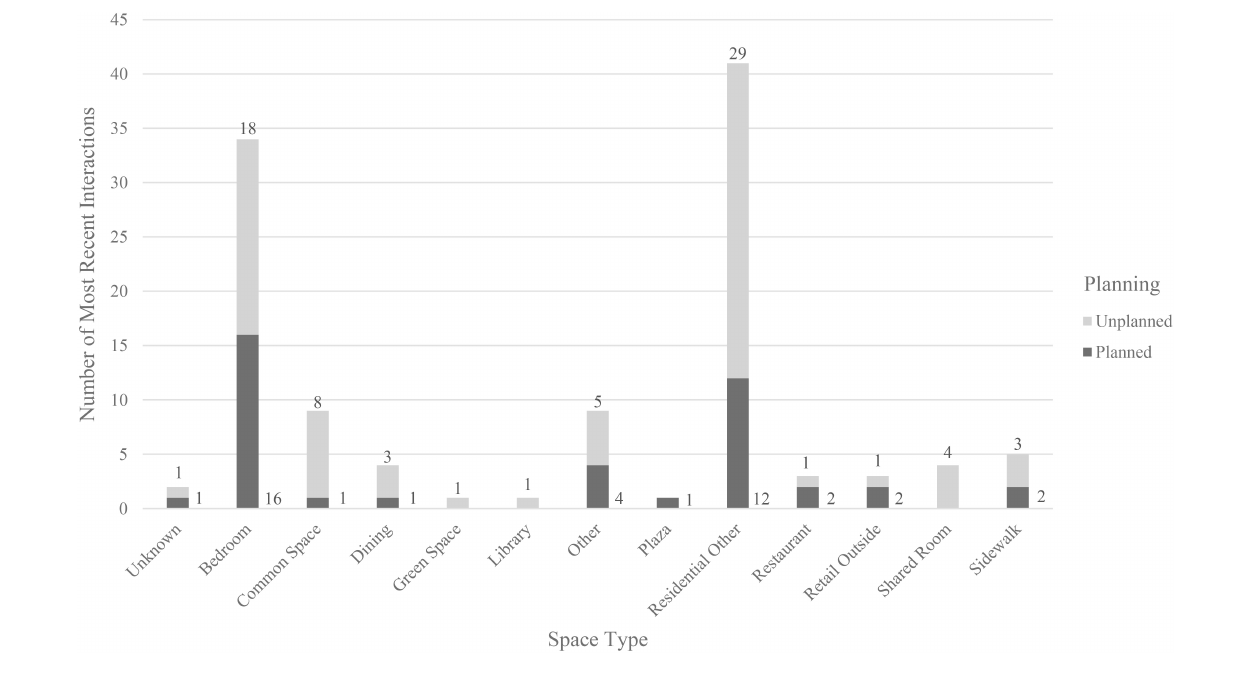
FIGURE 5 | Number of total interactions, by space type and